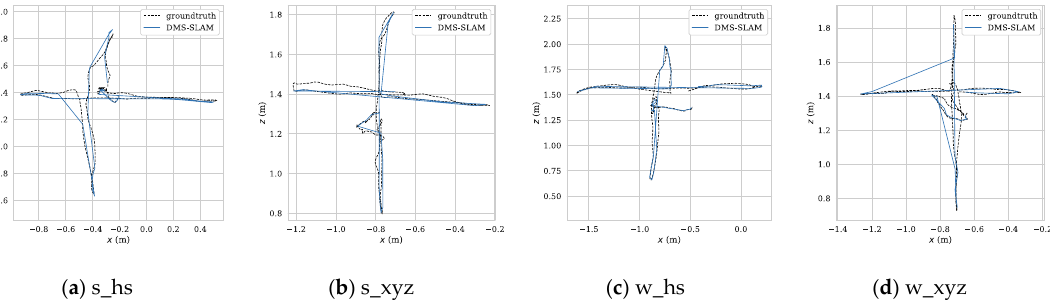
Figure 13. ( a – d ) We use Sim (3) for trajectory alignment and plot pose tracking graphs in low dynamic (s_*) and high dynamic (w_*) scenes of the DMS-SLAM system use monocular camera. Where x and z represent the horizontal direction.